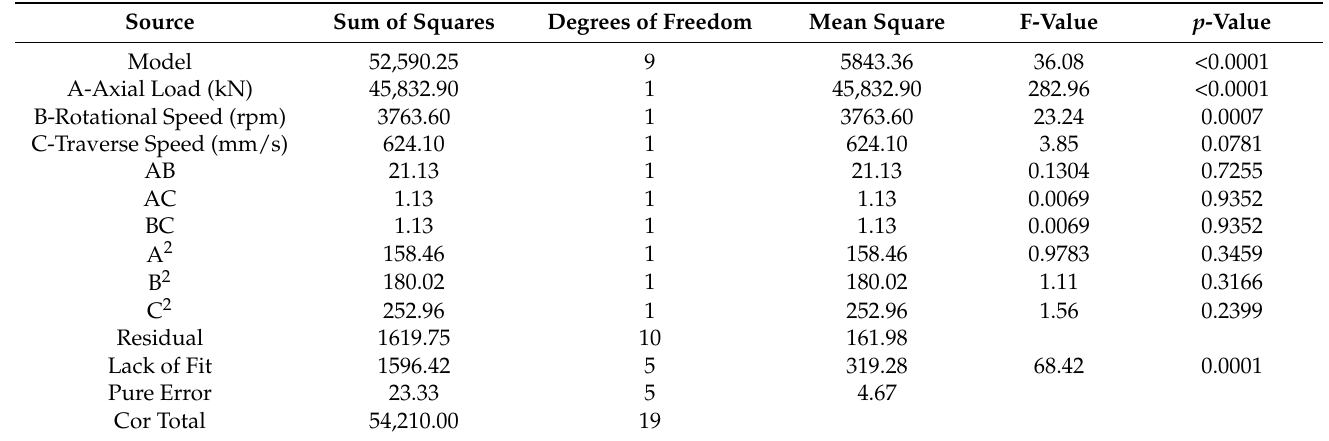
Table 7. ANOVA for quadratic model—Response 3: Bond strength (B s ).